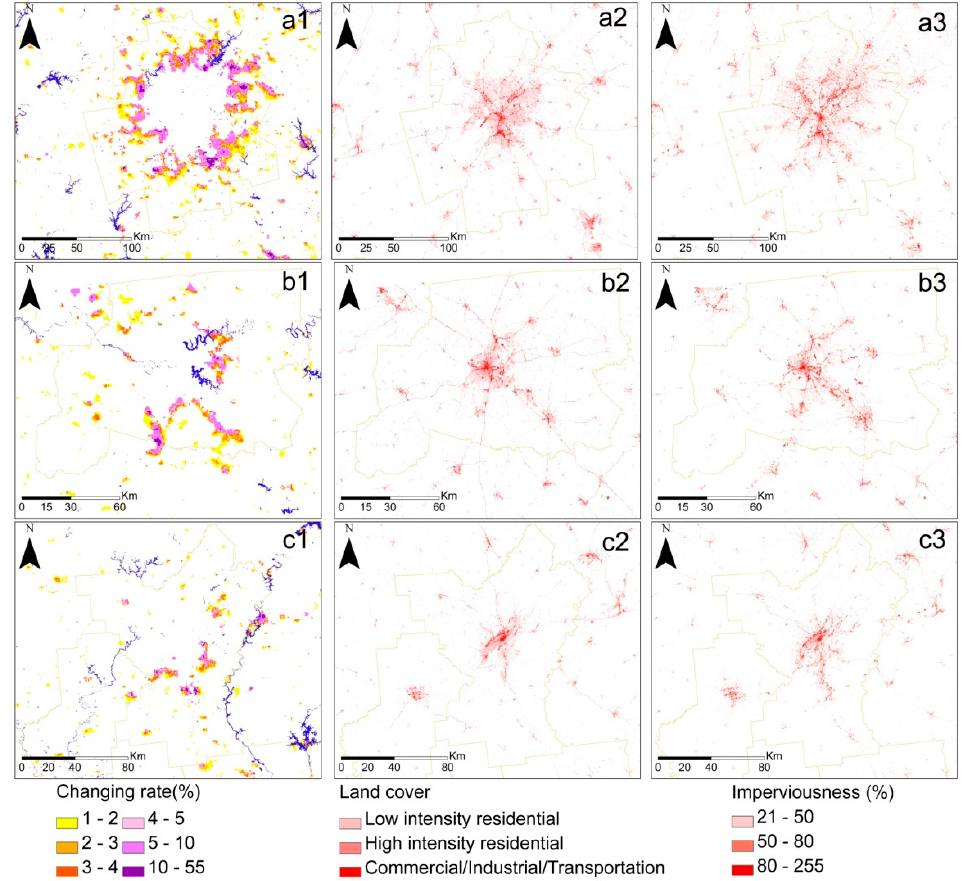
Figure 4. Comparison of VANUI changing trends with NLCD land cover products in 1992 and percentage of developed imperviousness products 2011 for three subsets. ( a1 – a3 ) Atlanta-Sandy Springs-Marietta, GA metro area; ( b1 – b3 ) Nashville-Davidson-Murfreesboro-Franklin, TN metro area; and ( c1 – c3 ) Birmingham-Hoover, AL metro area.